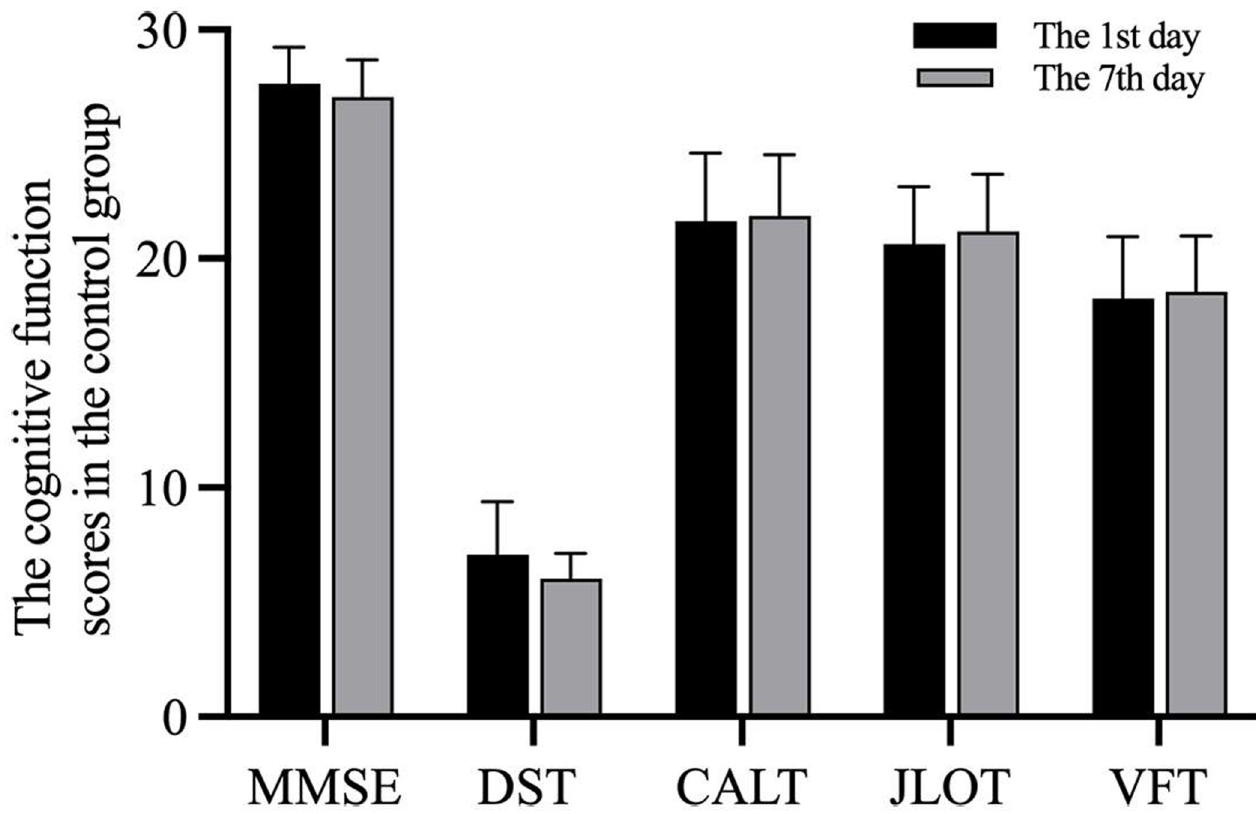
Fig 2. The cognitive function scores from the control group. MMSE: Mini-Mental State Examination; CALT: Chinese Auditory Learning Test; DST: Digital Span Test; VFT: Verbal Fluency Test; JLOT: Judgment of Line Orientation Test.